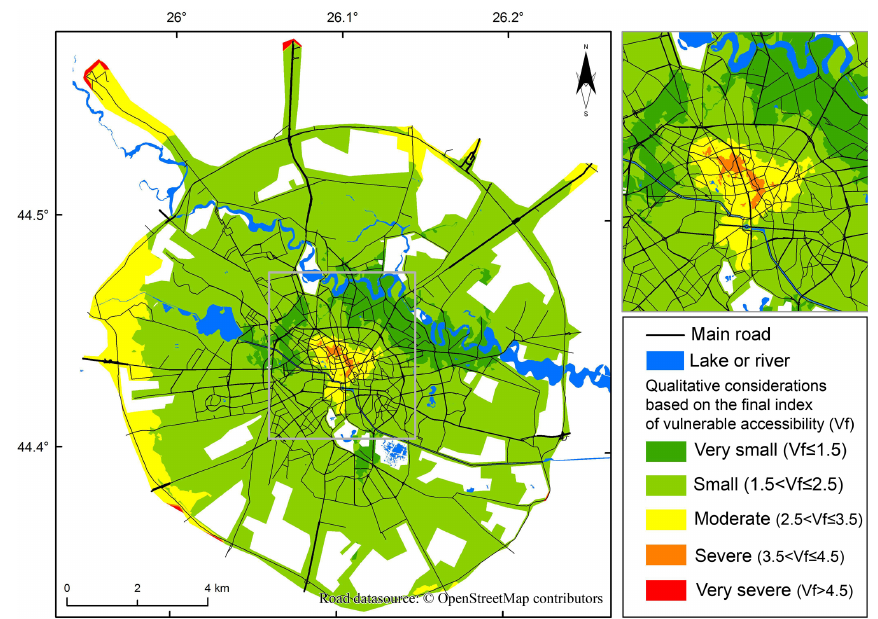
Figure 7. Final map showing qualitative values for the combined final index of vulnerable road network accessibility ( V f ) for Bucharest.